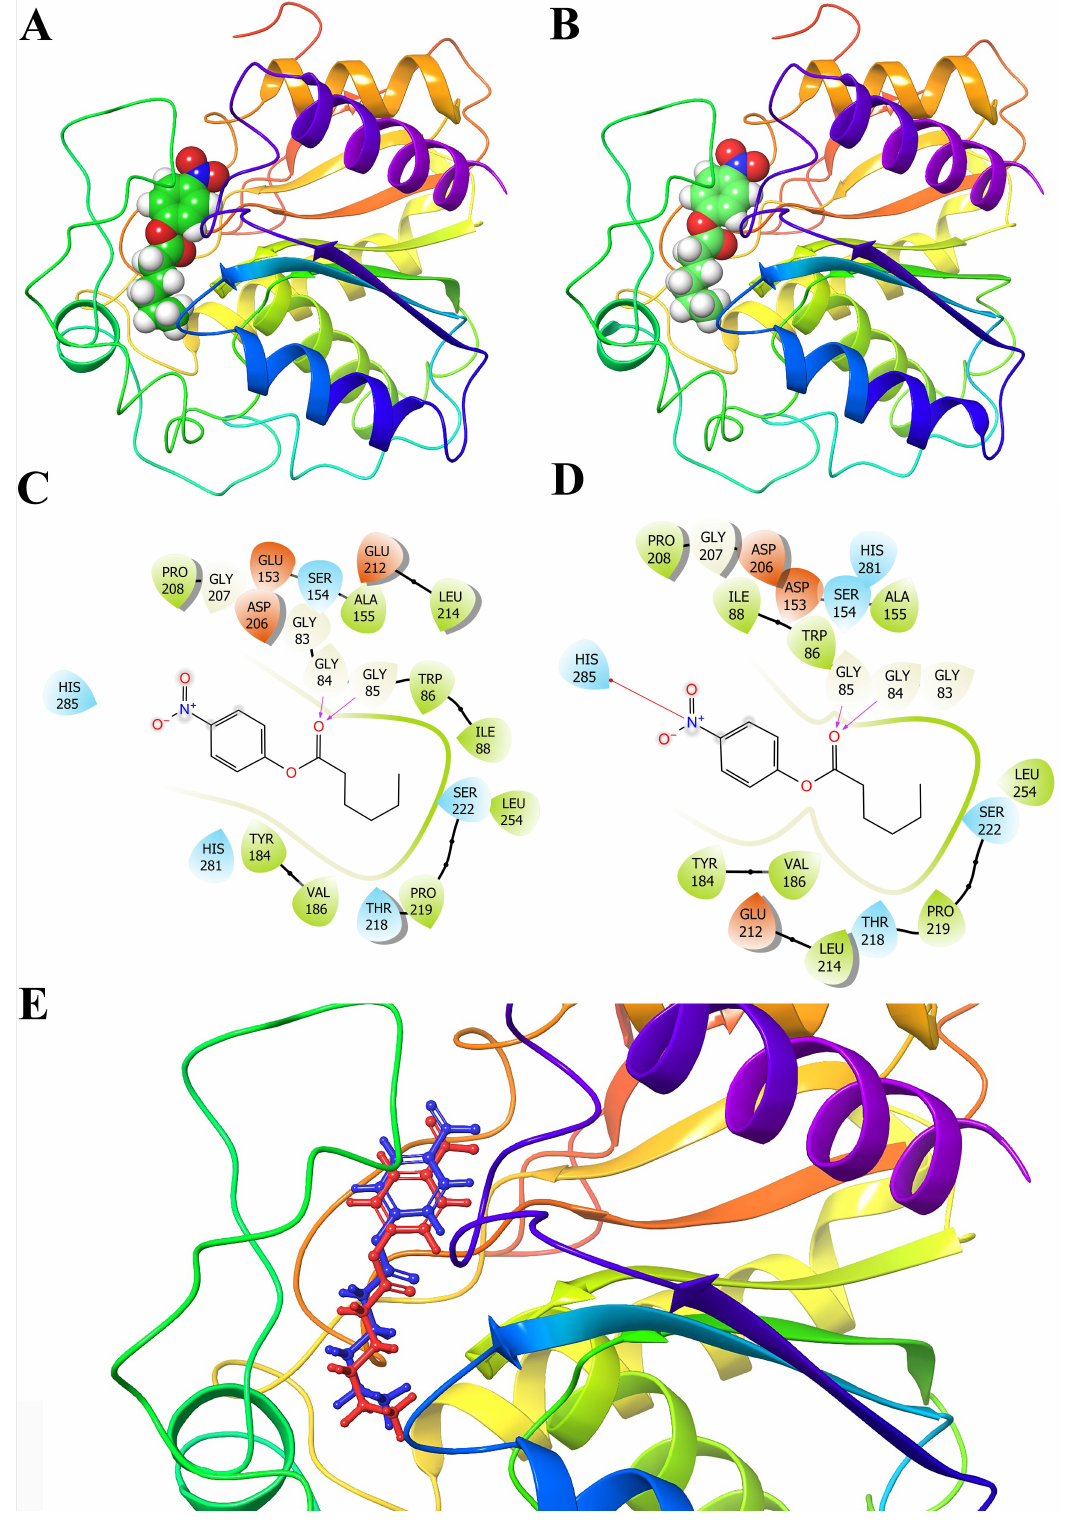
Figure 5. Structural analysis of the esterase. ( A ) Overall structure of Est19 modeled with p NPC6. ( B ) Overall structure of E154D substitution modeled with p NPC6. The structure revealed that they had a classical α / β hydrolase fold with 8 β